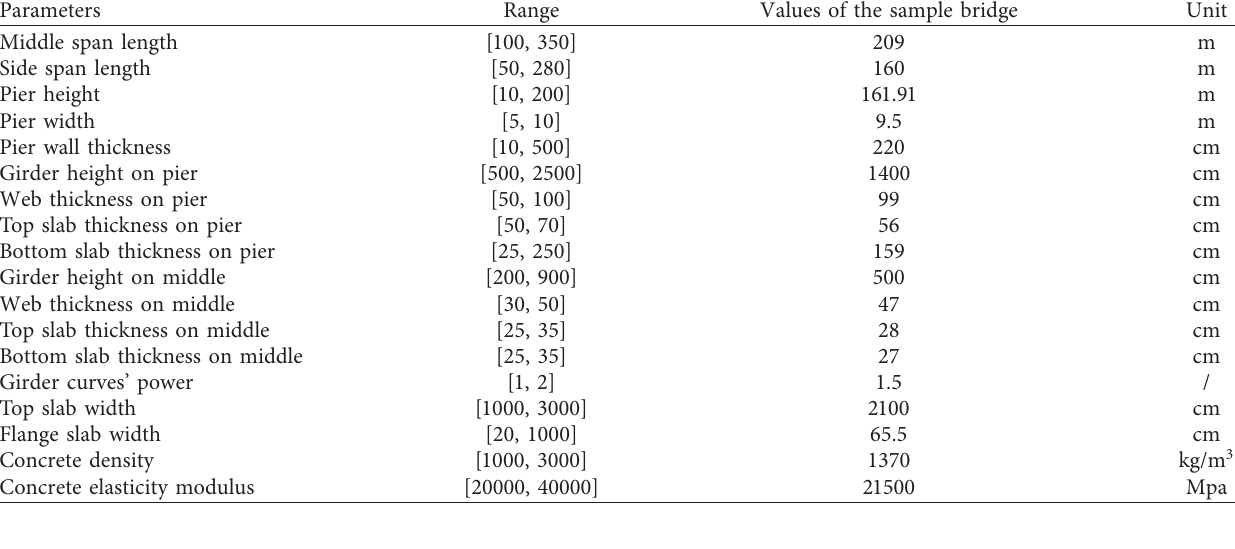
Table 1: Geometric and material